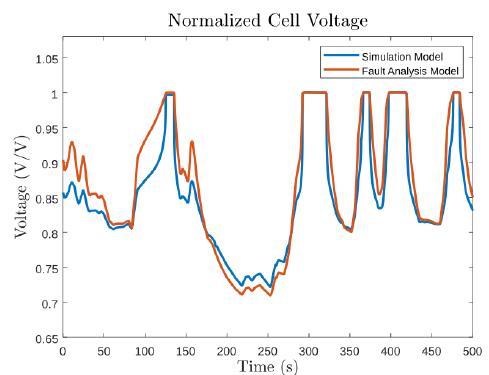
Figure 3. Comparison of normalized cell voltage between simulation model and fault analysis model.